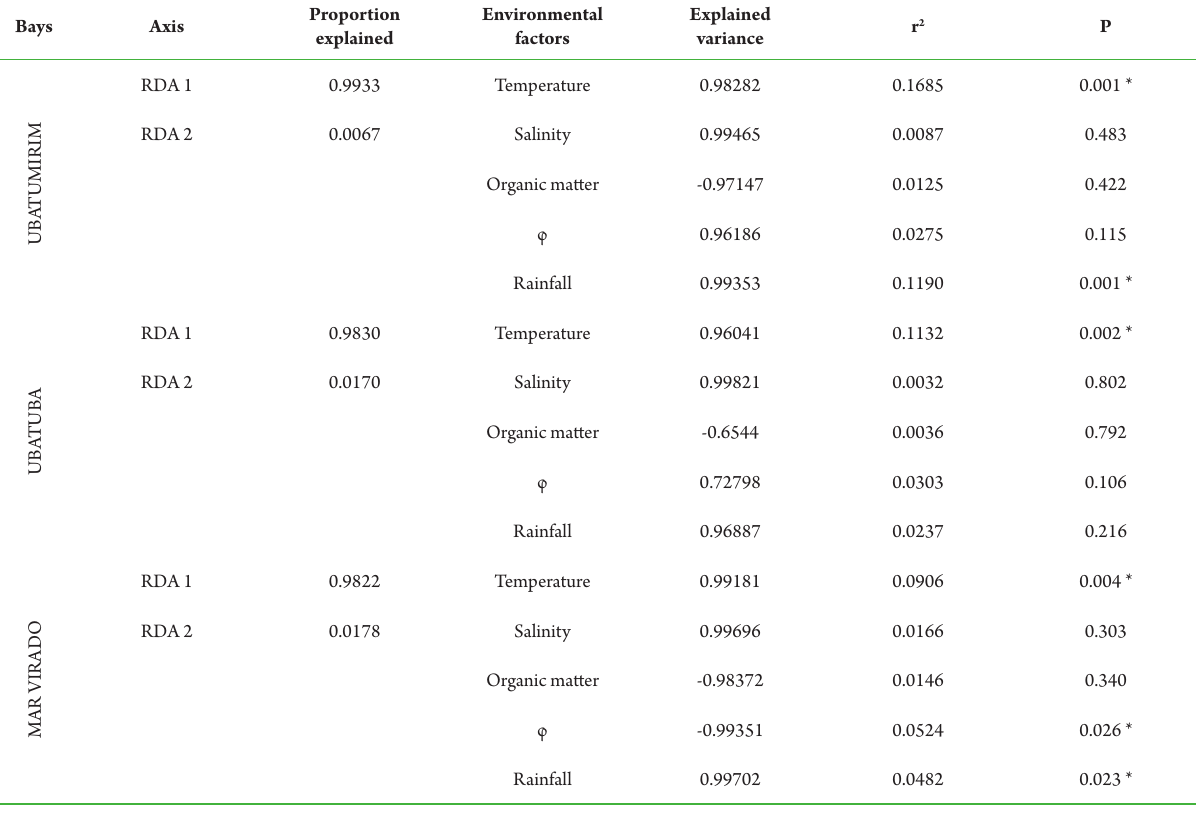
Table 4. Redundancy analysis (RDA) of the abundance of Farfantepenaeus brasiliensis and F. paulensis in relation to environmental variables that best explained the variation of the sampling data in three bays in the Ubatuba region, from January 1998 to December